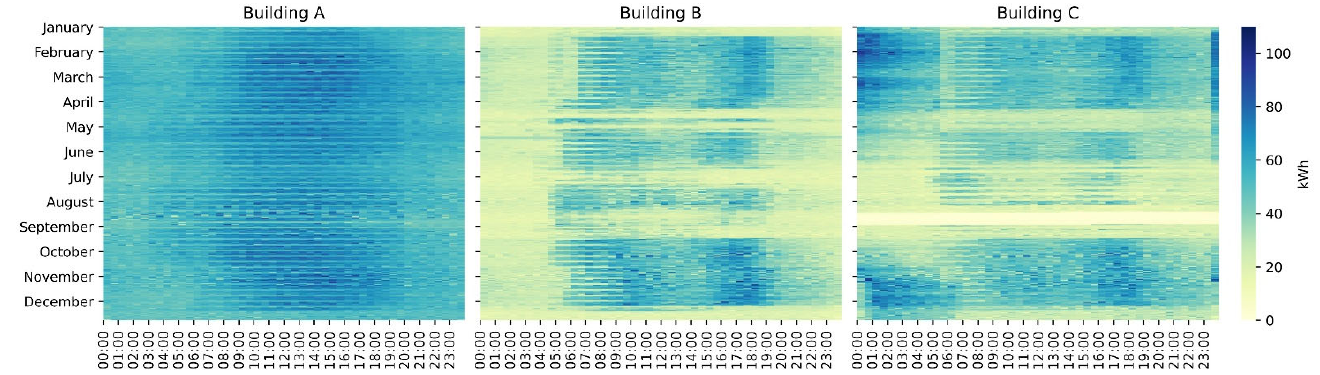
Figure 8. Building A, B, and C half ‐ hourly energy demand in kWh during 2019 .